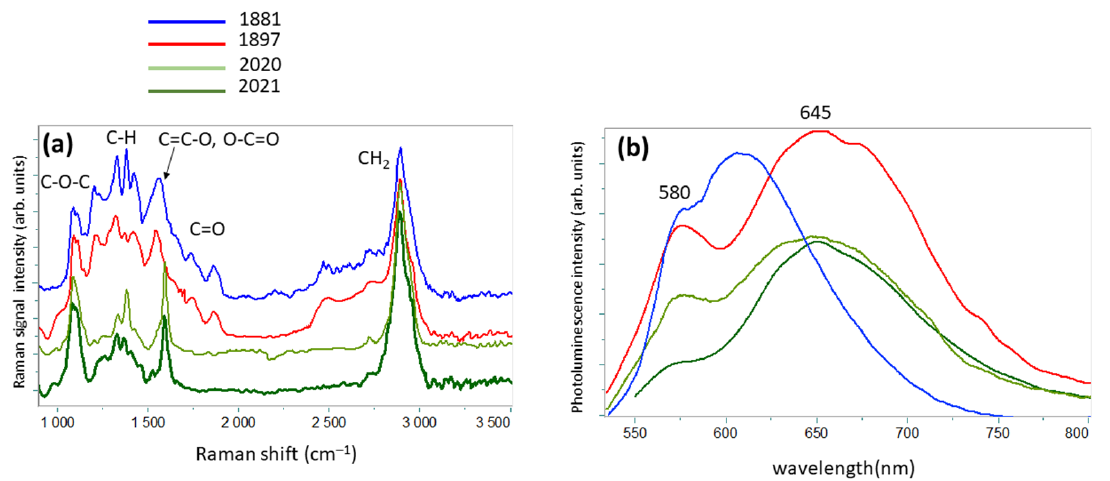
Figure 8. ( a ) Raman and ( b ) luminescence spectra from XIX century paper compared with those of modern paper.